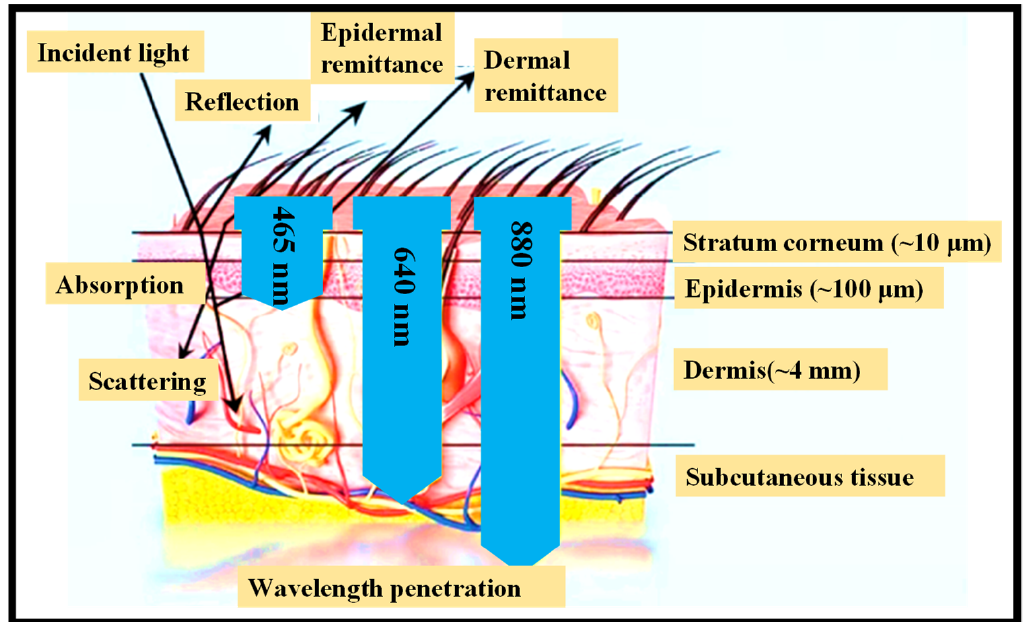
Figure 5. At different sites in the skin layers, incident light displays reflection, absorption, and scattering effects. In terms of λ , light penetrates into the skin [68].